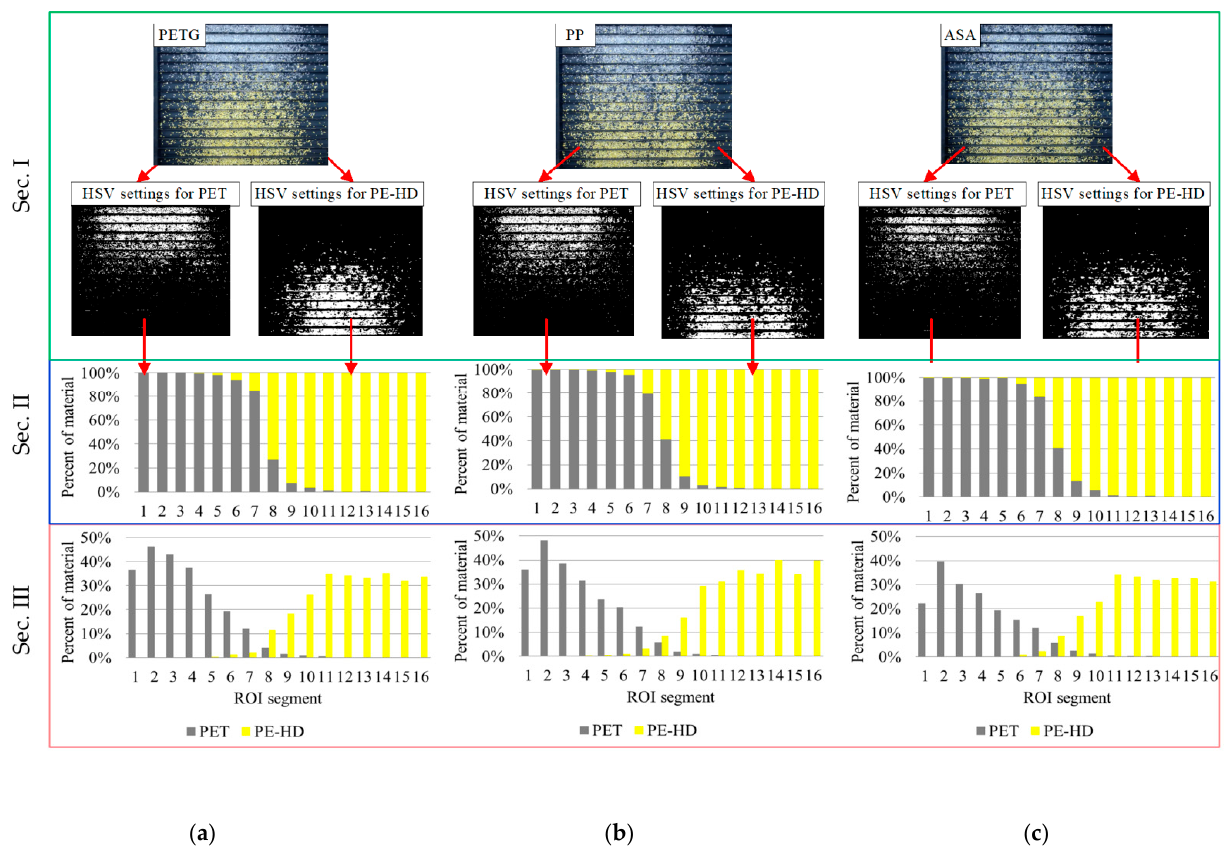
Figure 15. Electrostatic separator ( a ), the percentage ratio of PET (gray) to PE-HD (yellow) particles as determined by the image from a dedicated vision system in a container with ( b ) PP, ( c ) PET-G, ( d ) ASA (Sec. I—splitting the mixture of plastics into two sets of materials; Sec. I—percentage share of PET and PE-HD in each box; Sec. III—percentage content of PET and PE-HD in relation to the surface of the boxes).